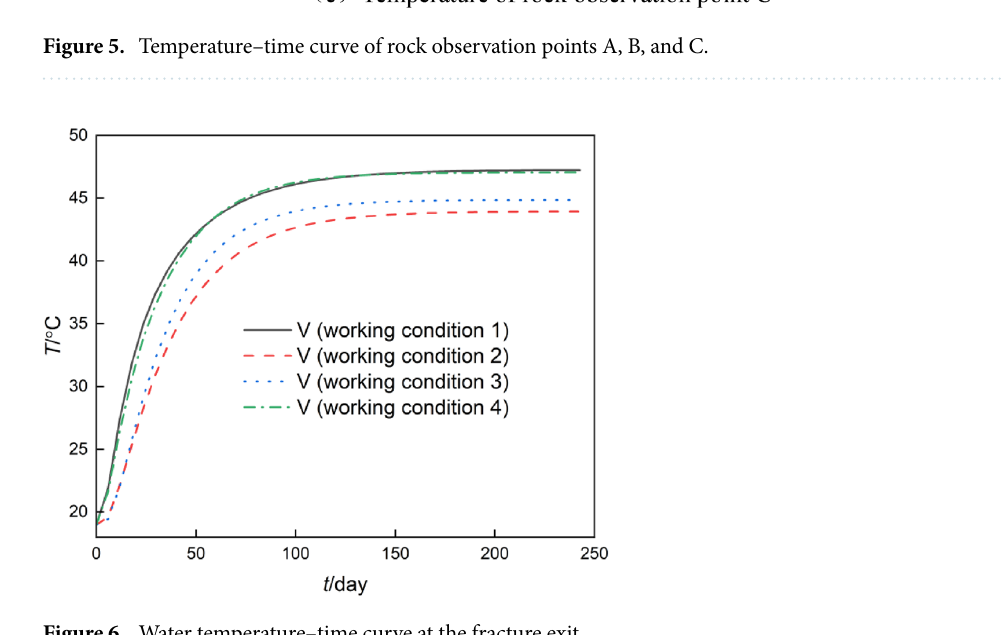
Figure 6. Water temperature–time curve at the fracture